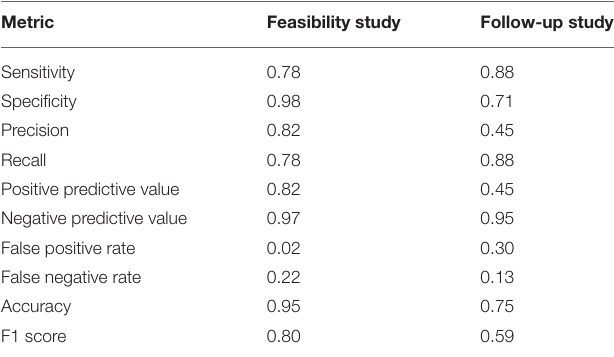
TABLE 3 | GBCA reduction initiative: quantitative performance evaluation from the feasibility and the follow up validation studies. Metric